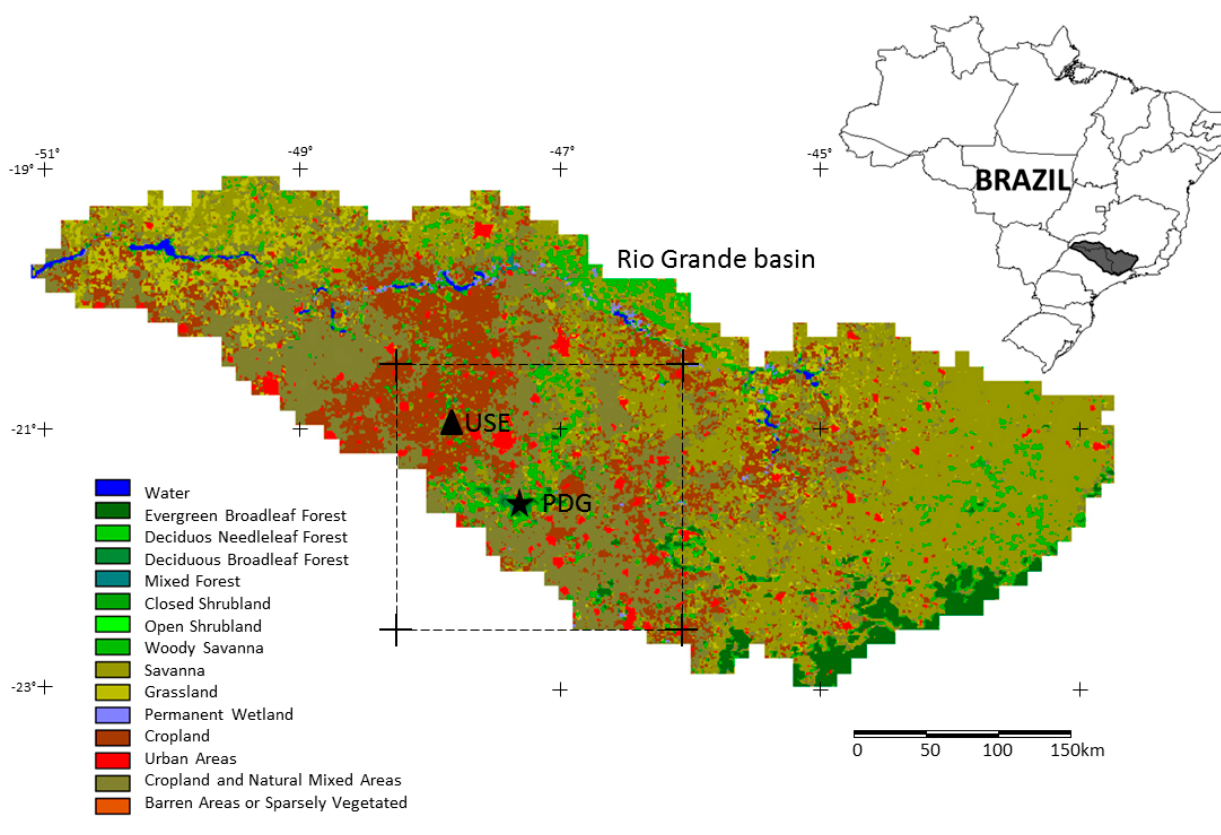
Figure 1. Spatial location of the flux tower sites used in this study. The base map is the MODIS land-cover classification during 2001. Dotted area represents a ~2° ×~2° square selected to cover the flux tower sites and to apply SEBAL. The overlay between MGB-IPH (basin) and SEBAL (dotted square) in the Rio Grande basin is about 38,100 km 2